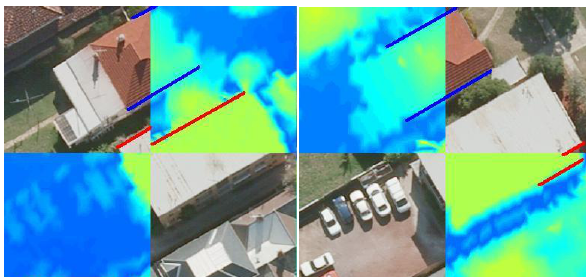
Figure 11. Registered Orthoimage and LiDAR DSM data highlighting matched features (blue lines) and blunders (red